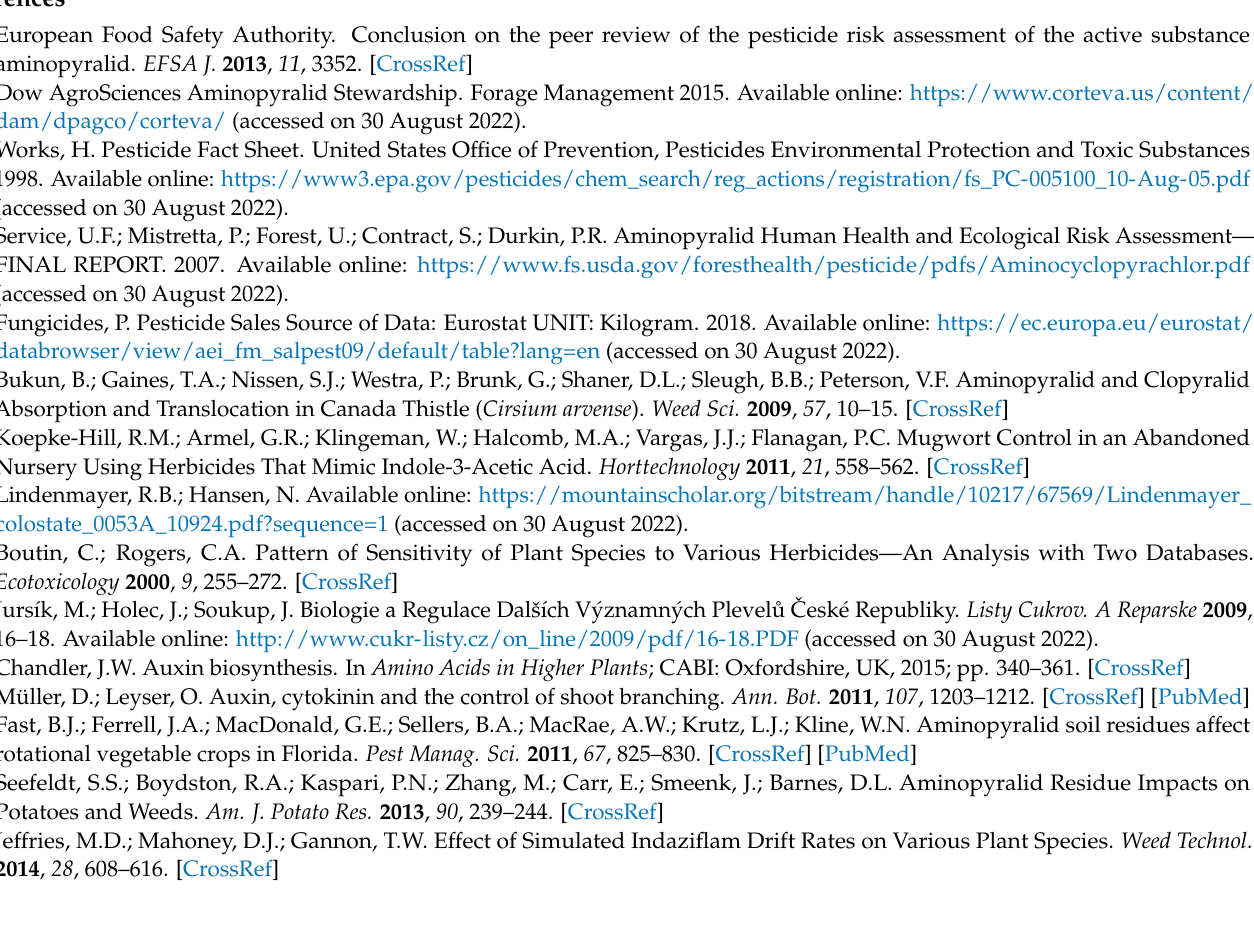
tomato plants. Figure S6: The illustrative images from the experiment. Table S1: Tomato seed germination (%) on aminopyralid-treated sand at different application doses (0, 0.6, 1.5, 3, 7.5 and 15 g/ha), Table S2: Injury, height, diameter of root collar and ewight in tomato plants with gradual aminopyralid treatment, Table S3: Two cultivars of tomato plants treated with three undiluted straw extracts and distilled water